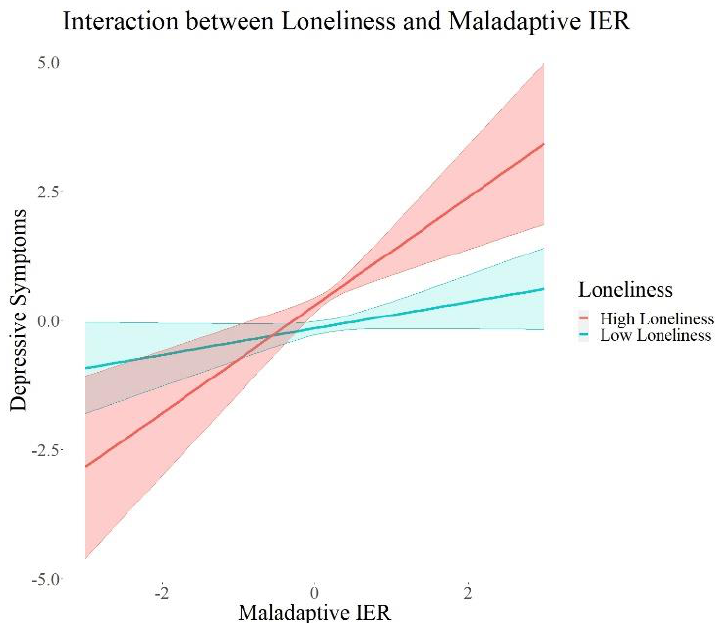
Figure 3. Interaction Effects between Loneliness and Maladaptive IER on Depressive Symptoms. Note . The shades behind the thicker lines represent the 95% confidence interval. All variables were standardized, and the scales on the graph represent standard deviations (i.e., 2 = 2 units of standard deviation).